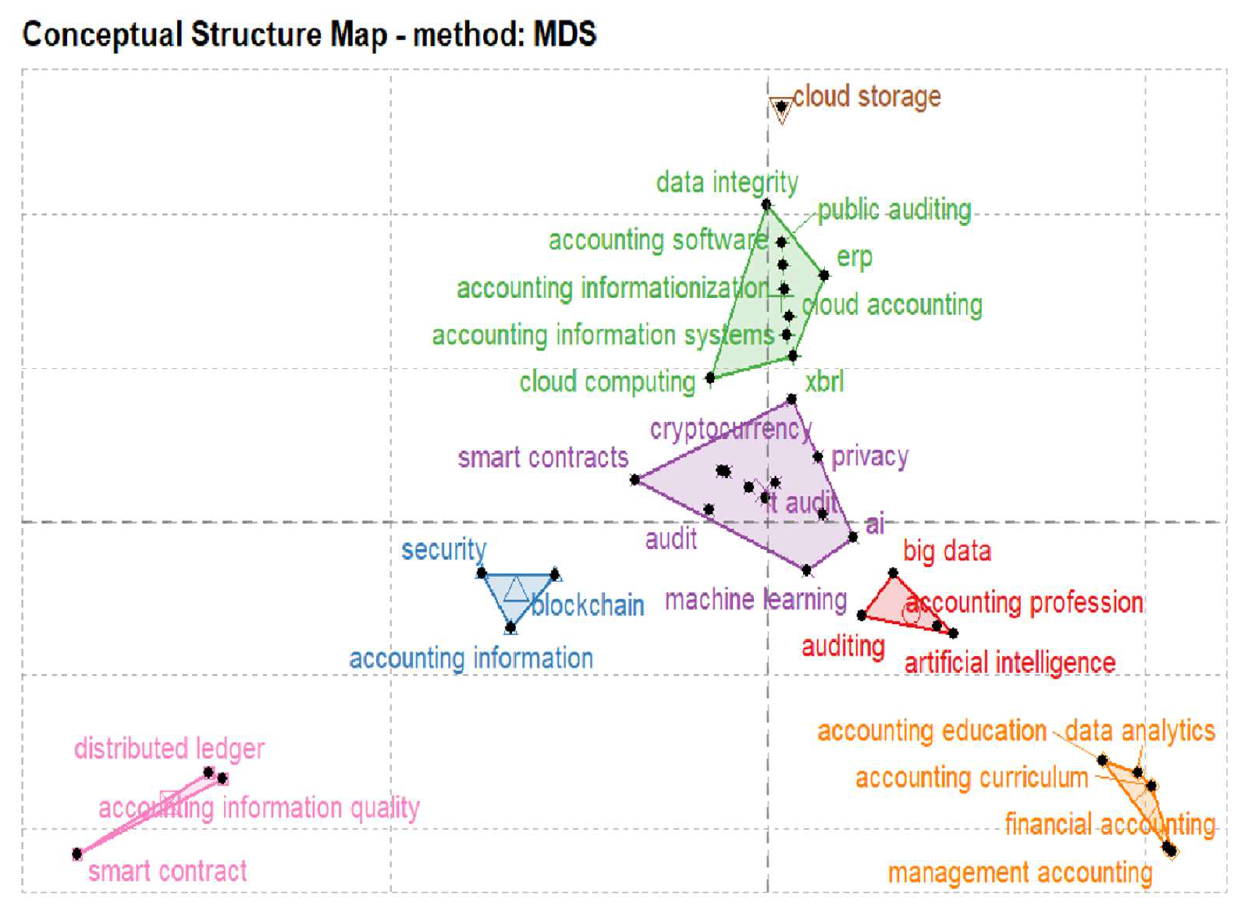
Figure 2. Conceptual structure map. (Source: author’s creation).